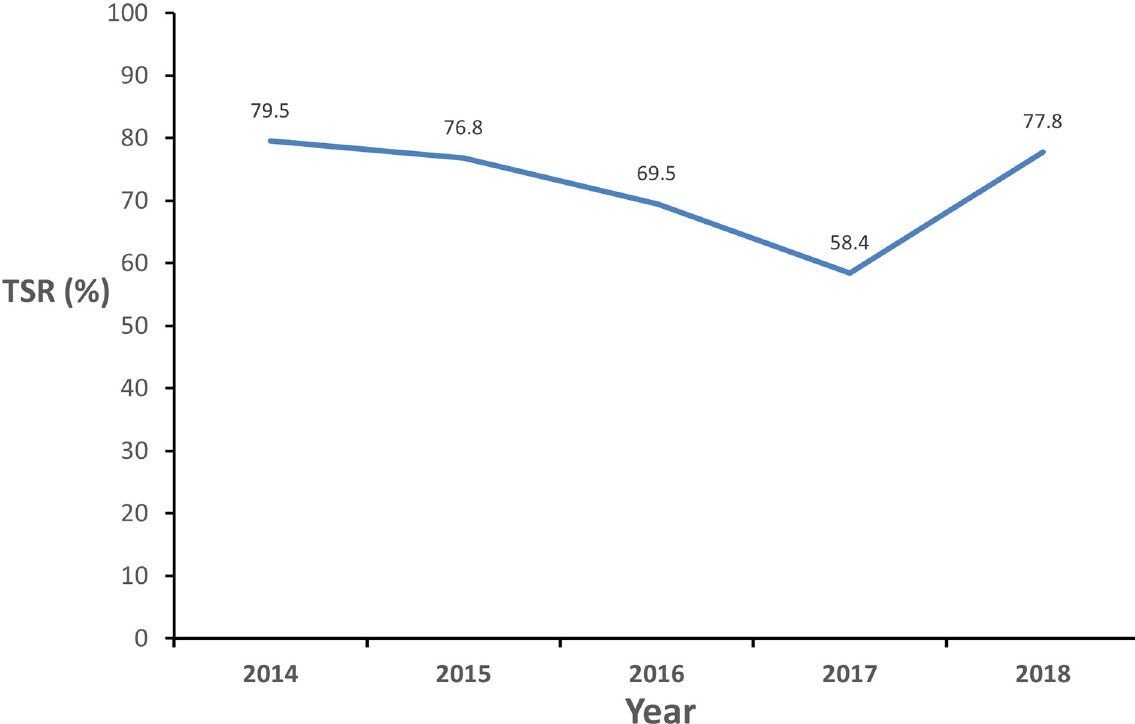
Fig 3. Trends of treatment success rates of TB patients in five main prison settings in Bauchi State from January 2014 to December 2018.